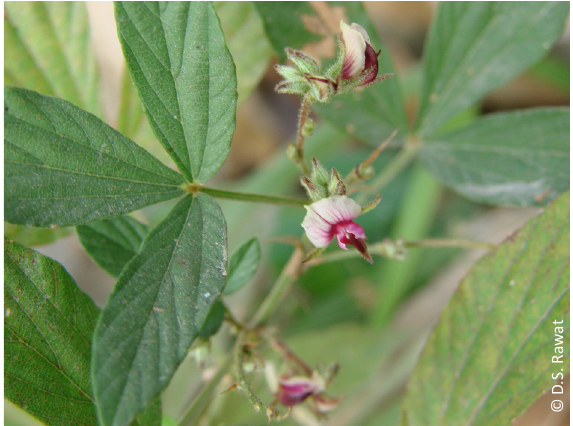
Image 5. Flemingia lineata (L.) Roxb. ex